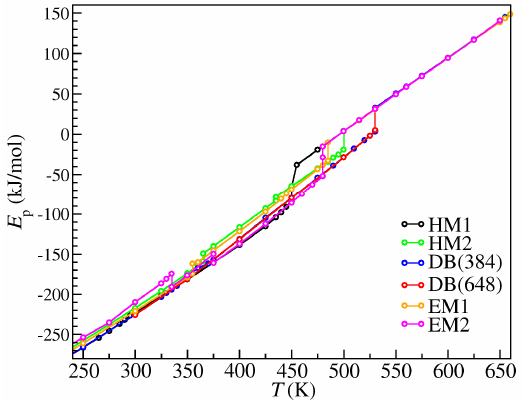
Figure 4. Caloric curve of one mole [C 14 Mim][NO 3 ] in each system during